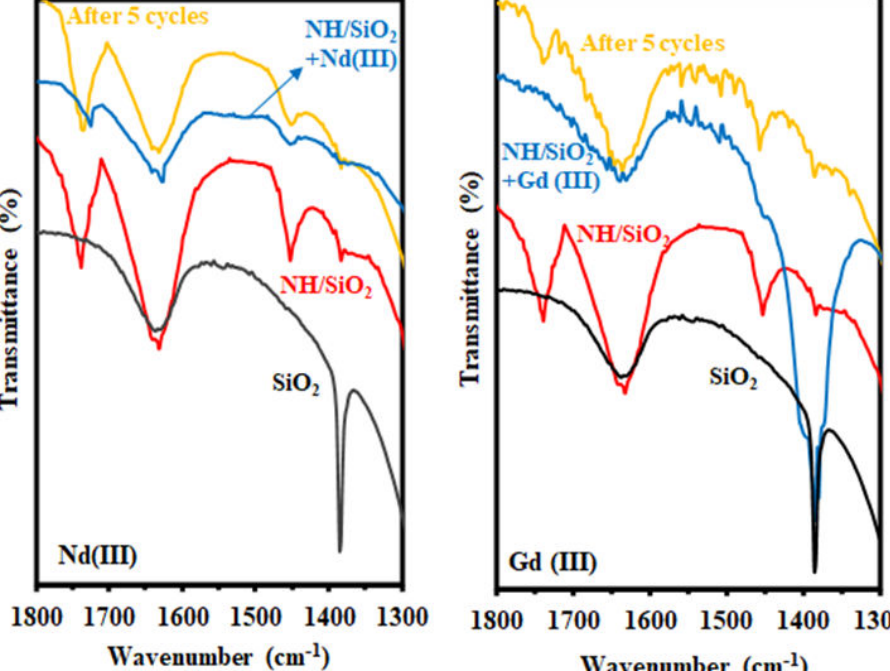
Figure 2. Selected wavenumber range (1800–1300 cm − 1 ) for FTIR spectra of SiO 2 , functionalized sorbent (NH/SiO 2 ), sorbent after Nd(III) and Gd(III), and after five sorption and desorption